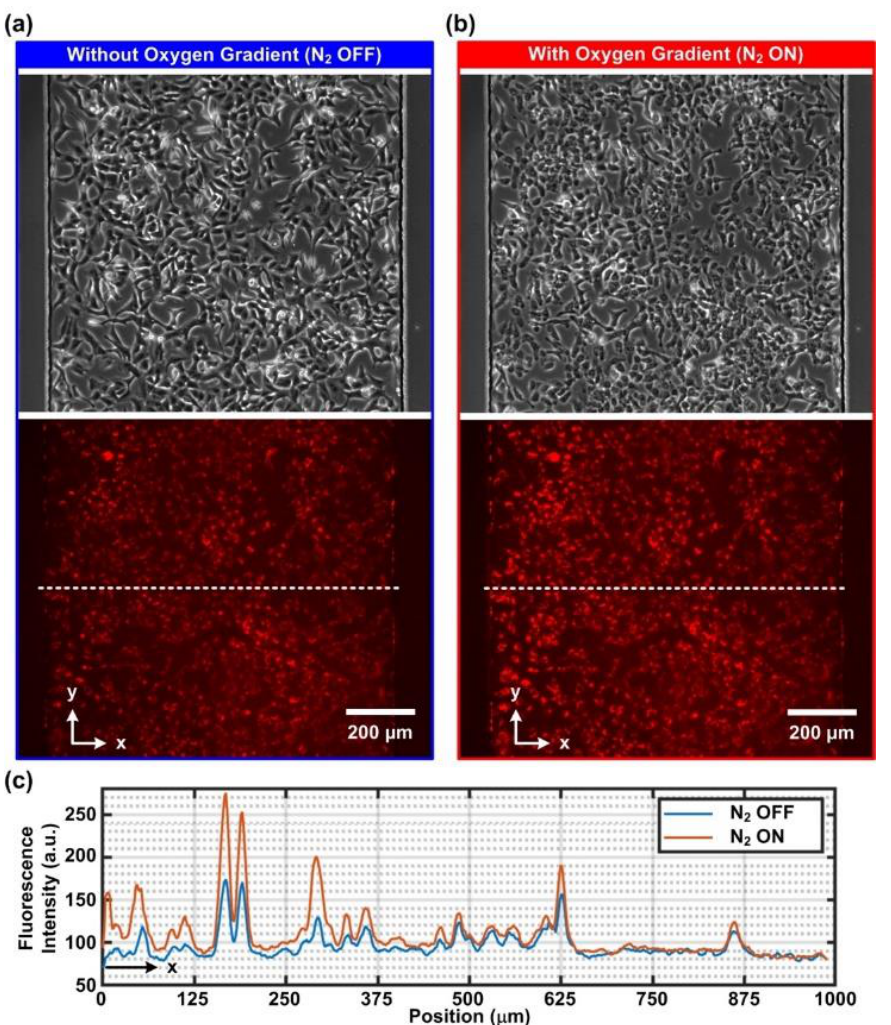
Figure 4. Phase contrast and fluorescence images of A549 cells treated with the intracellular oxygen-sensitive reagent (MitoXpress Intra) under ( a ) normoxia (N 2 OFF) and ( b ) oxygen gradient (N 2 ON) conditions. ( c ) Representative line profiles of the fluorescence intensity across the width of the channel under the normoxia and oxygen gradient conditions. Compared to the normoxia condition (N 2 OFF), higher fluorescence intensity on the left-hand side under the oxygen gradient condition (N 2 ON) indicates lower intracellular oxygen tension within the A549 cells. Furthermore, the fluorescent images under both N 2 OFF (normoxia) and N 2 ON (oxygen gradient) conditions were quantitatively analyzed, and the fluorescence intensity profiles are plotted in Figures 3c and 4c for the AoSMCs and A549 cells, respectively. The plots show that the fluorescence intensity of the oxygen-sensitive dye was higher for the cells closer to the left side channel under the oxygen gradient condition when compared to the normoxic control ones. This suggests the lower intracellular oxygen tension of the cells on the left side when the N 2 is on. In contrast, the fluorescence intensity for the cells close to the right side channel remained similar for both conditions, indicating a similar intracellular oxygen tension. The results confirmed that the intracellular oxygen tensions varied from low to high from left to right, following the trends of the oxygen gradient generated in the cell culture channel. In order to quantify the intracellular oxygen tension variation during the alternative normoxia (N 2 OFF) and oxygen gradient (N 2 ON) conditions, the average